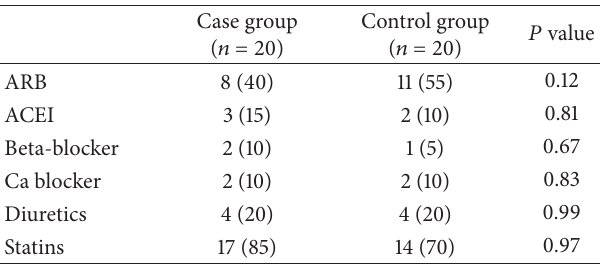
Table 3: Baseline characteristics in 40 studies patients by